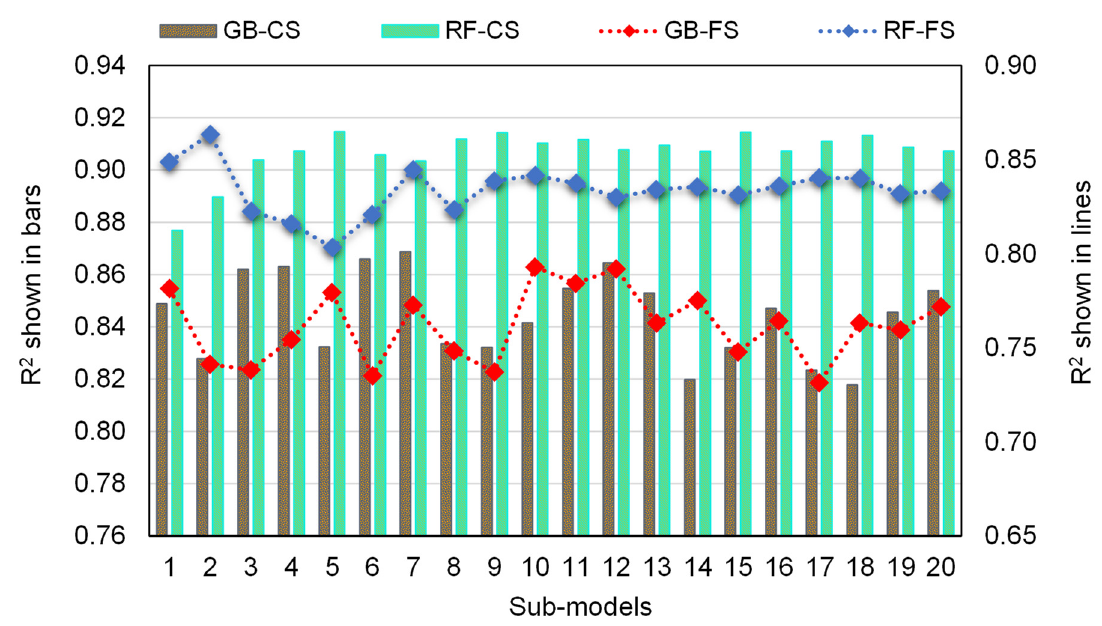
Figure 16. Correlation coefficients (R 2 ) of submodels.